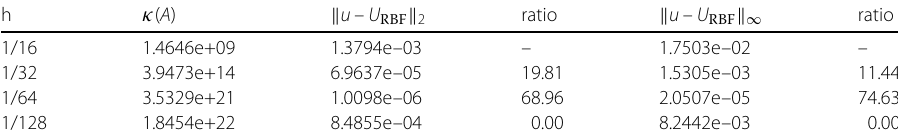
Table 7 The errors for the RBF collocation method in two norms